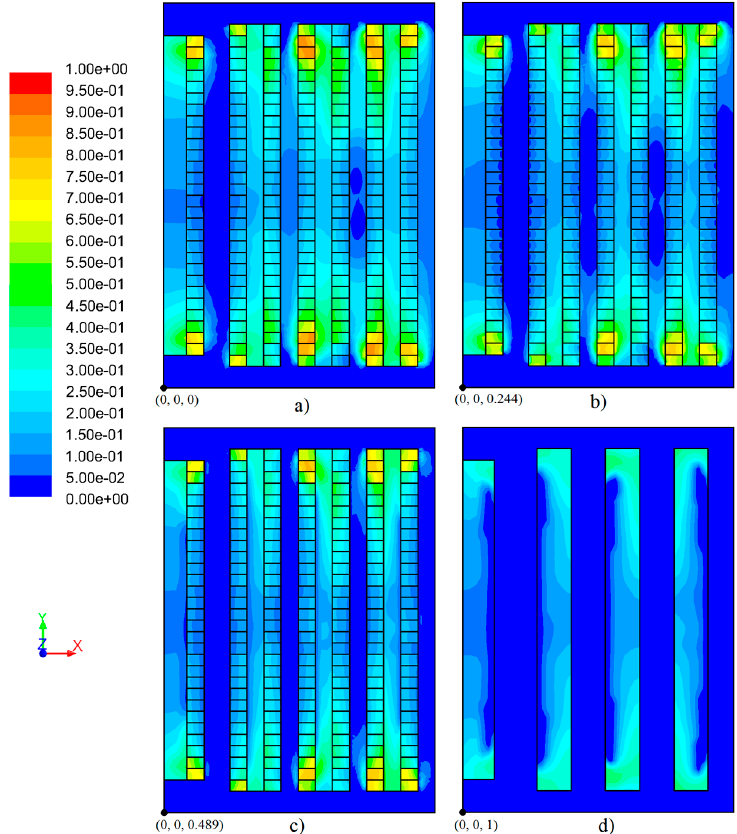
Figure 6. The results of the field of temperature in the x-y plane through the planes: ( a ) z adm = 0; ( b ) z adm = 0.244; ( c ) z adm = 0.489; and ( d ) z adm = 1. In the case of the maximum air flow dimensionless velocity, v adm = 1, the temperature field predictions can be seen in Figures 7 and 8 for the y and z planes, respectively.